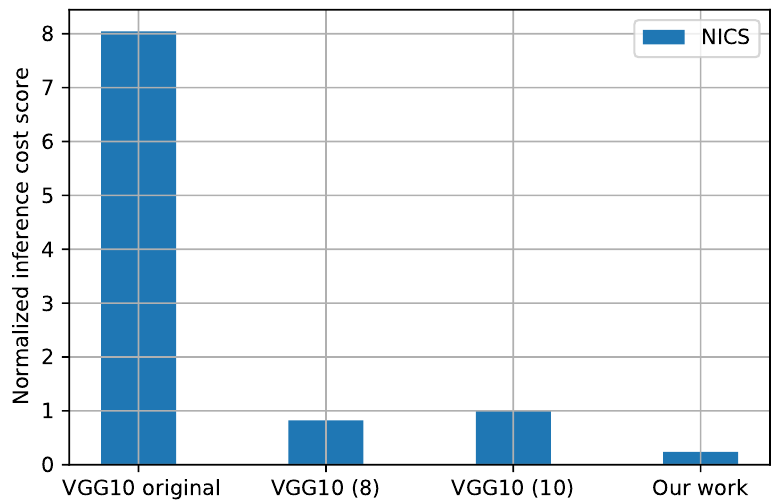
Figure 8. Modulation classification accuracy of the original (unquantized) model and the quantized versions with different SNR values.